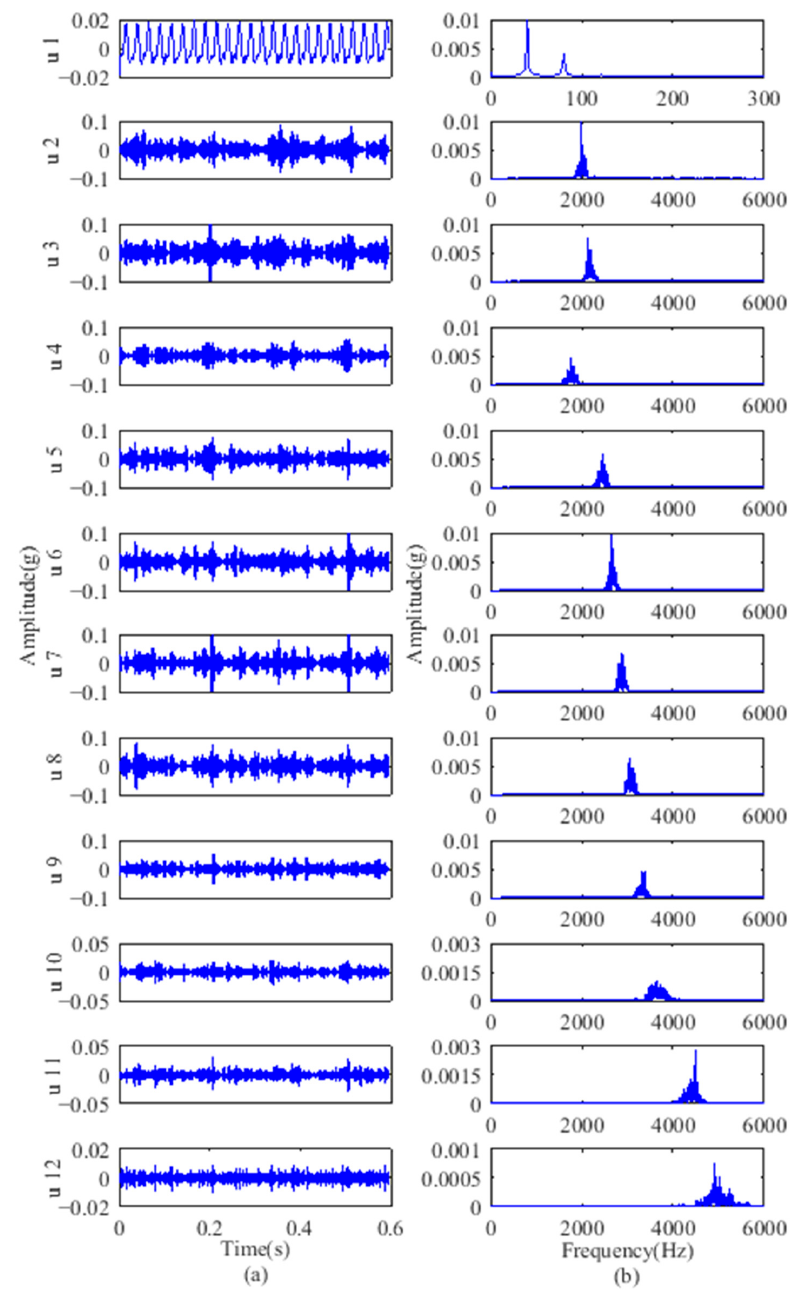
Table 2. The partition of modes using variable mode decomposition (VMD) and intrinsic mode functions (IMFs) using ensemble empirical mode decomposition (EEMD).